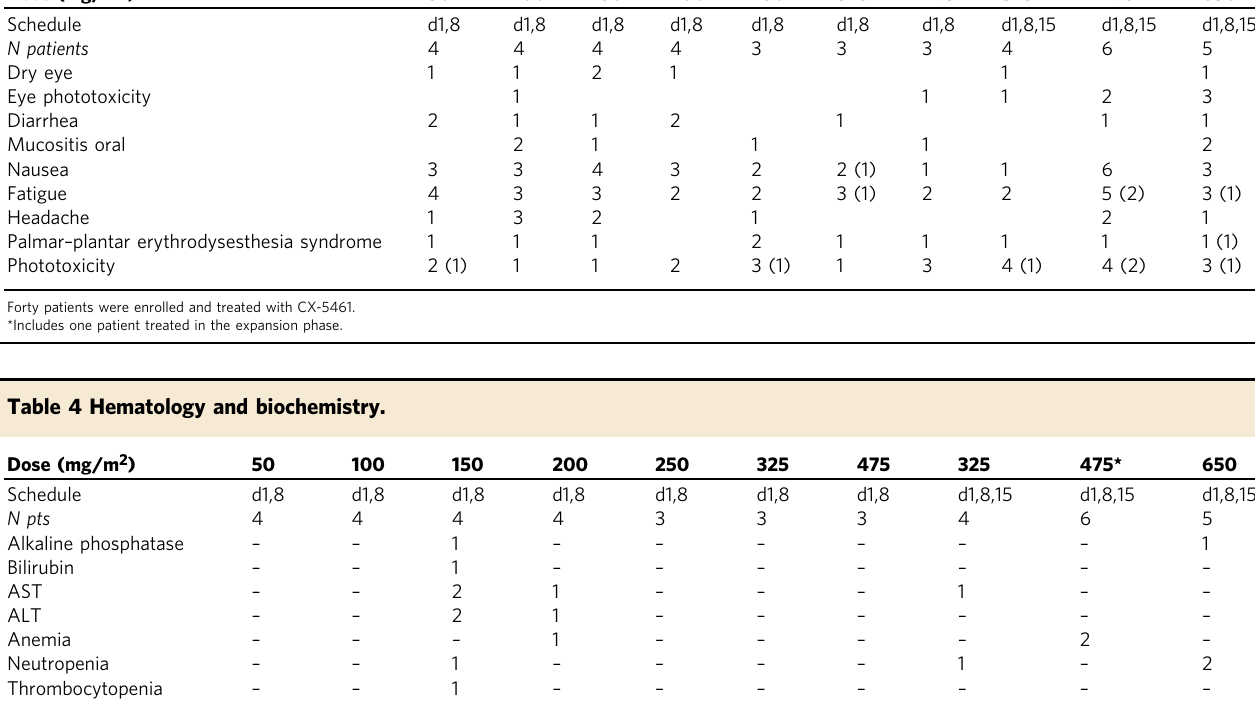
Table 3 Select non-hematologic adverse events of any causality by dose level: all grades. Dose (mg/m 2 )